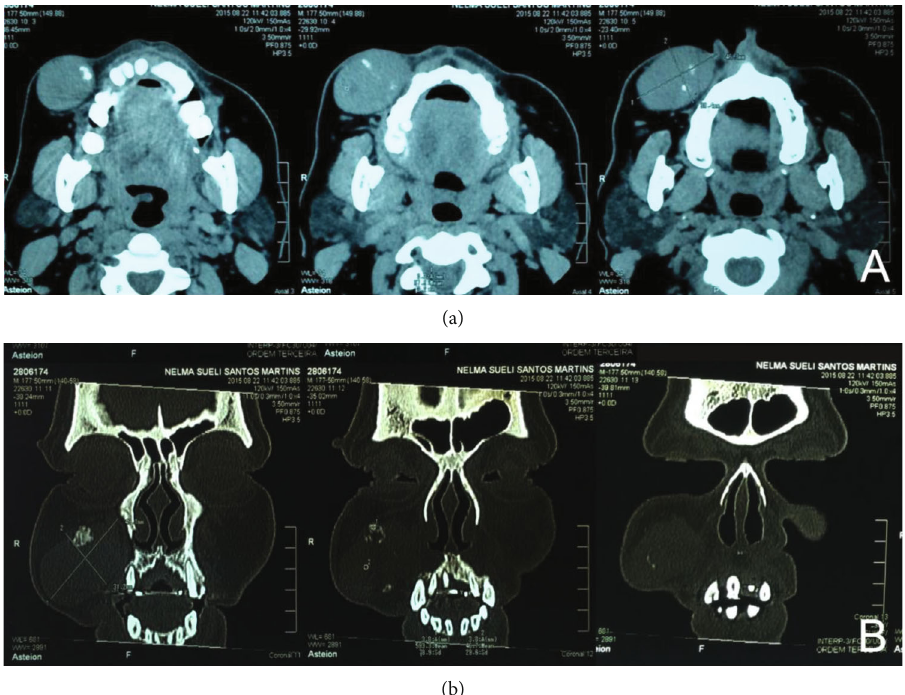
Figure 2: (a) Axial plane and (b) coronal plane, showing the lesion as a dense mass of soft tissue with de fi ned contours and foci of calci fi